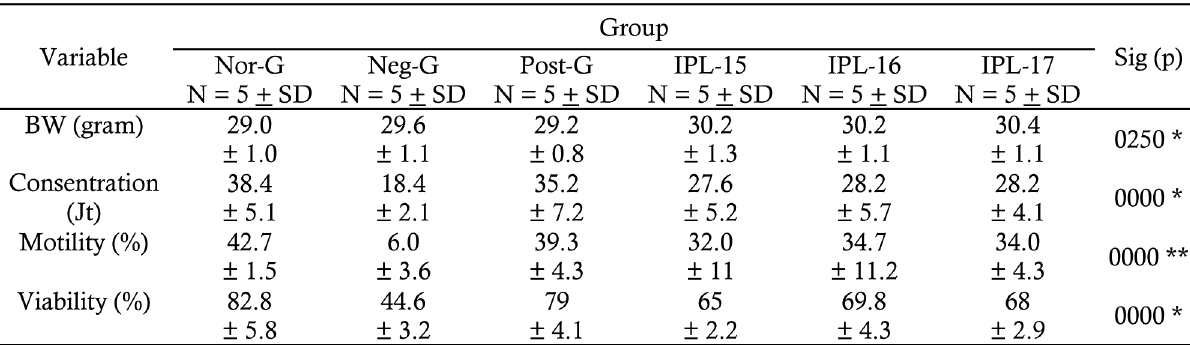
Table 1. Mean sperm concentration, motility, and viability in each